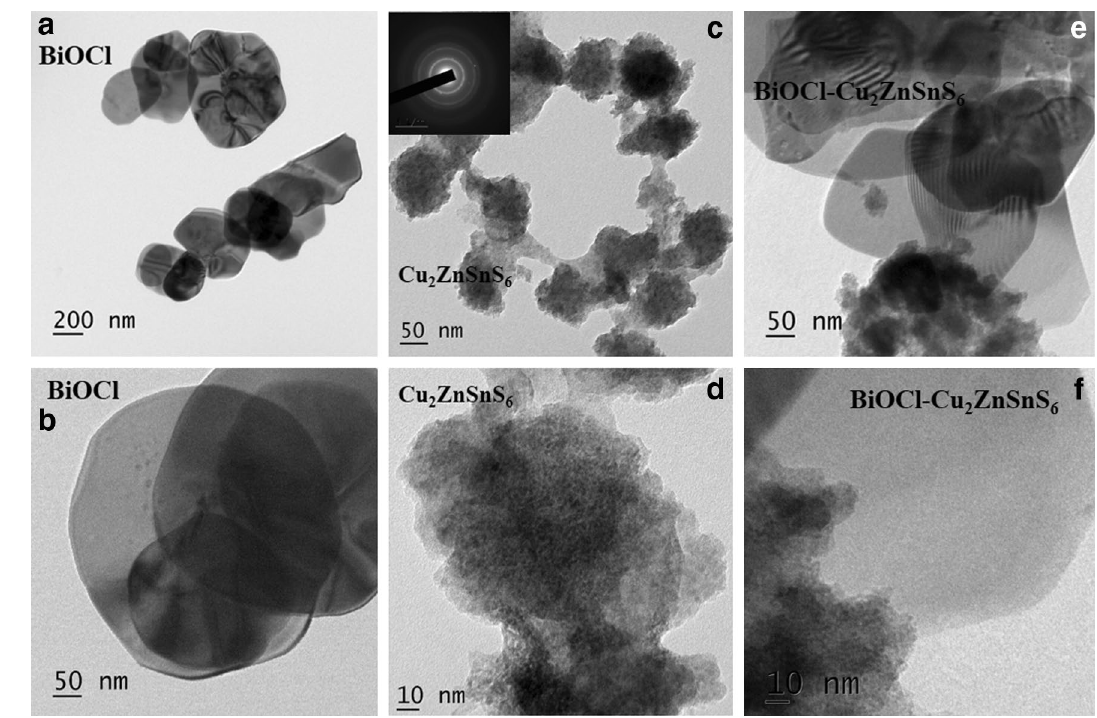
Fig. 2 TEM images of BiOCl ( a , b ), Cu 2 ZnSnS 4 QDs ( c , d ) and BiOCl–Cu 2 ZnSnS 4 -1( e , f )